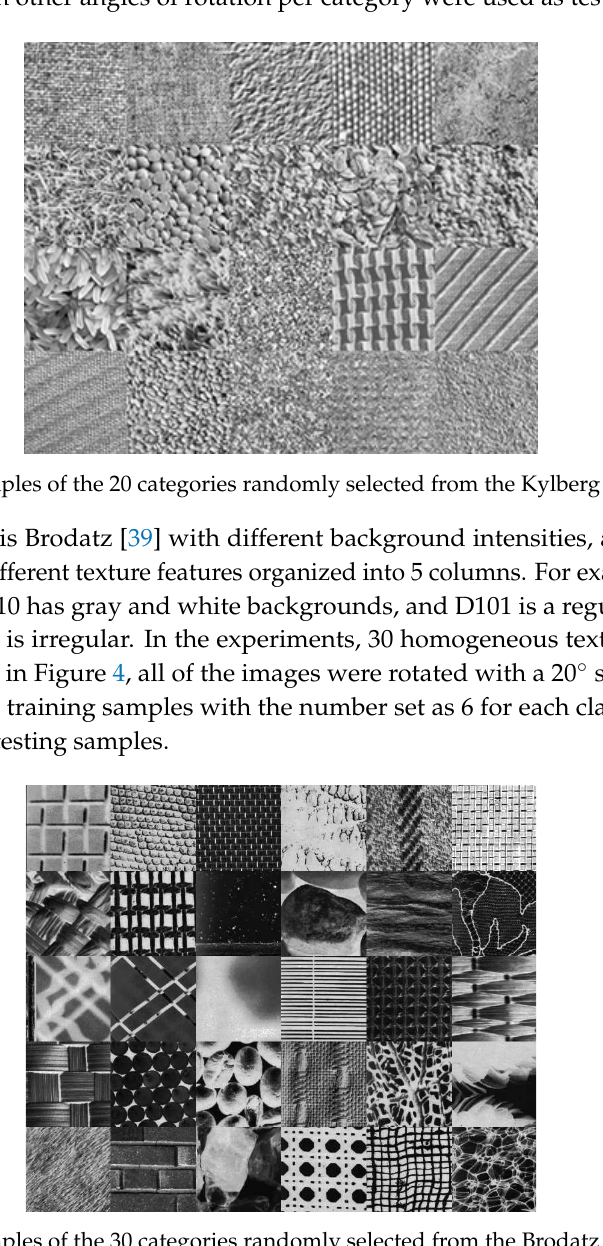
Figure 4. Samples of the 30 categories randomly selected from the Brodatz